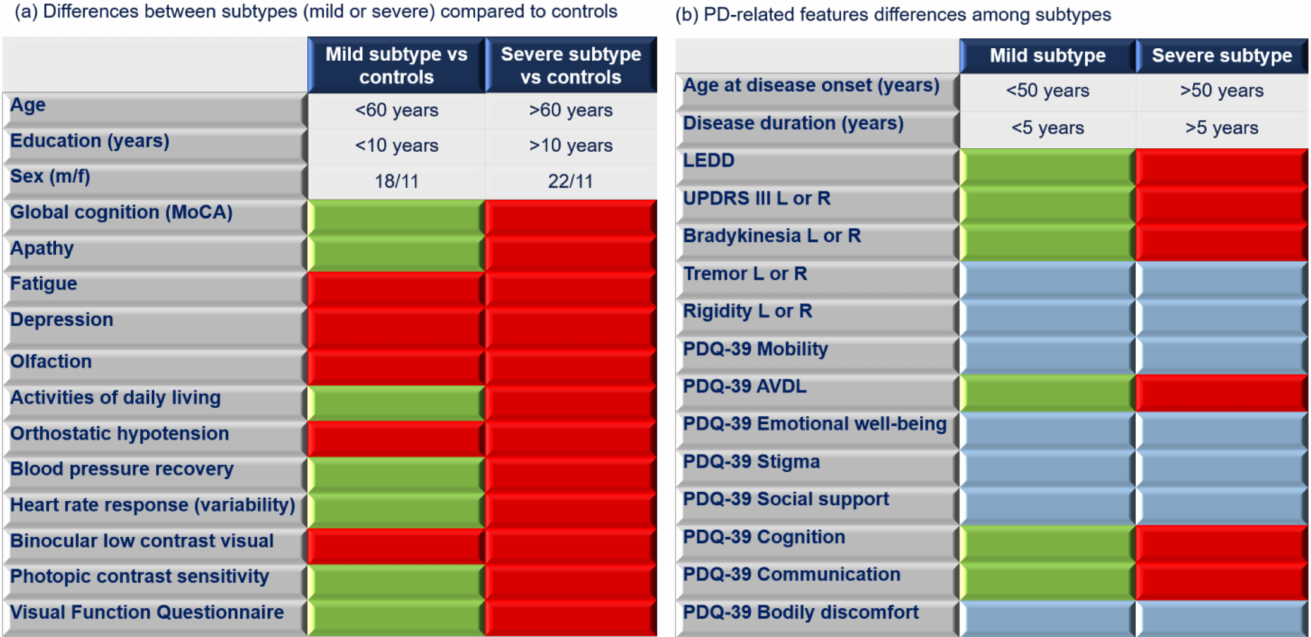
Figure 1. Dendrogram of patients clustered according to nonmotor data. Abbreviations: E46K-SNCA = E46K mutation of the alpha-synuclein gene; PD = Parkinson’s disease; DLB = Dementia with Lewy bodies.